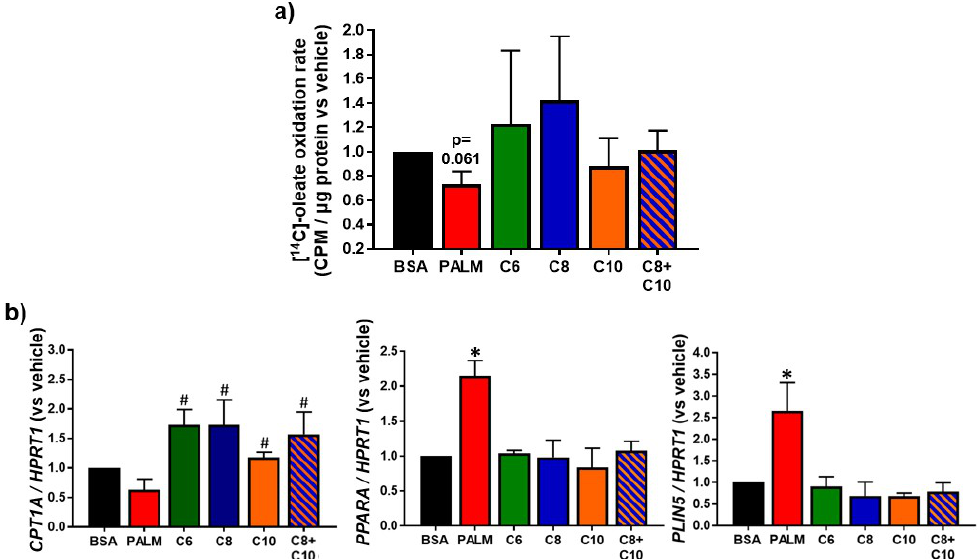
Figure 4. Effect of fatty acids on HepG2 lipid β -oxidation activity. HepG2 cells were treated 24 h with 0.25 mM PALM, C6, C8, C10, a C8 + C10 equimolar mix, or vehicle control (BSA). ( a ) ( 14 C)-oleate oxidation assay results relative to vehicle-treated control ( n = 4). ( b ) CPT1A, PPARA, and PLIN5 lipid